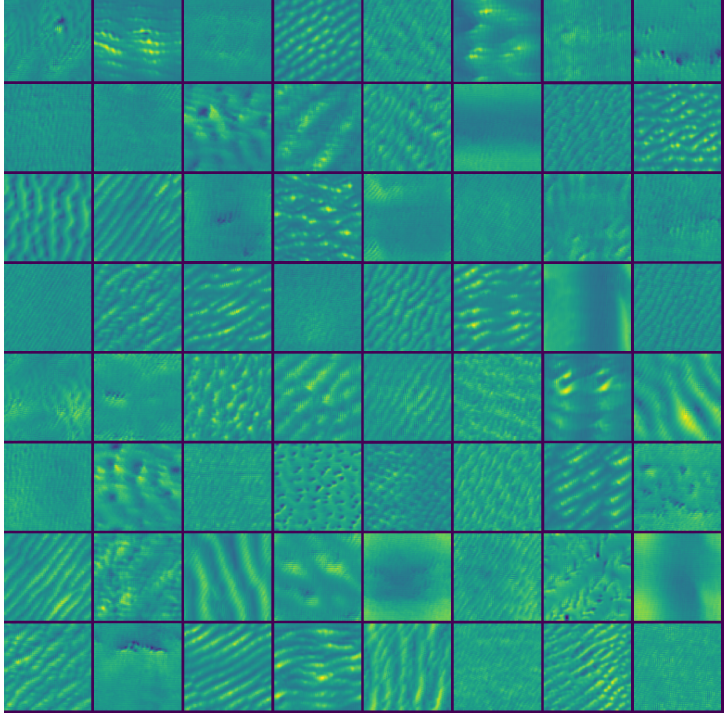
Figure 9. Filters visualization. We synthetically generated the input images that maximally activate 64 of the 512 filters in the first convolutional layer of the “Enc Block 512” at the bottom of the OFCN.